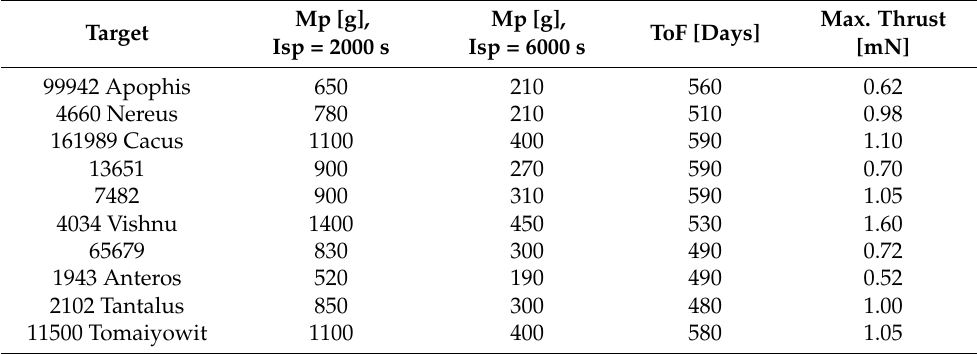
Table 4. Low-thrust analysis